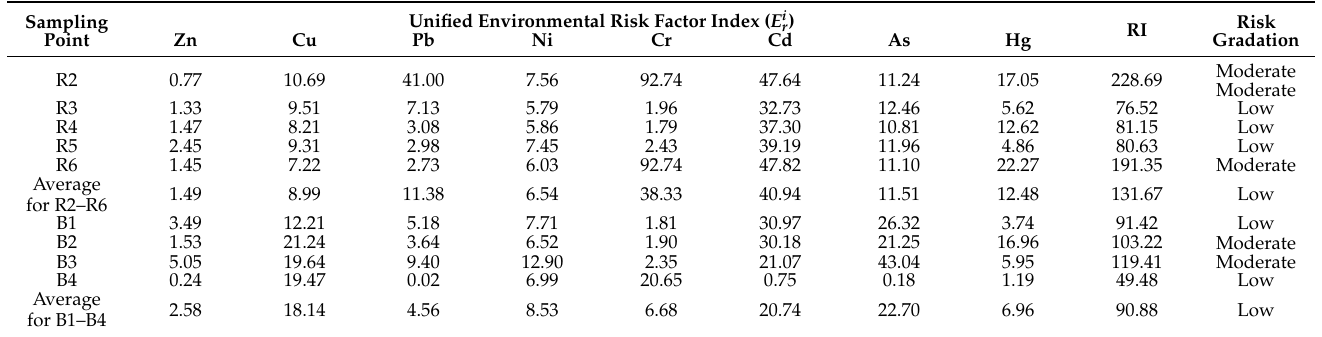
Table 7. Potential ecological risk assessment results of TE in sediments of the Kosva River and Kosva Bay.